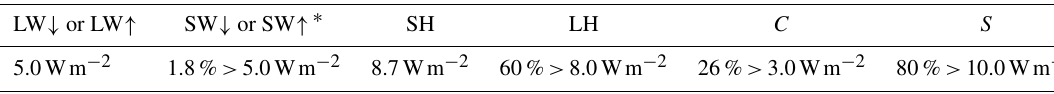
Table 1. Estimated uncertainty in each surface energy budget